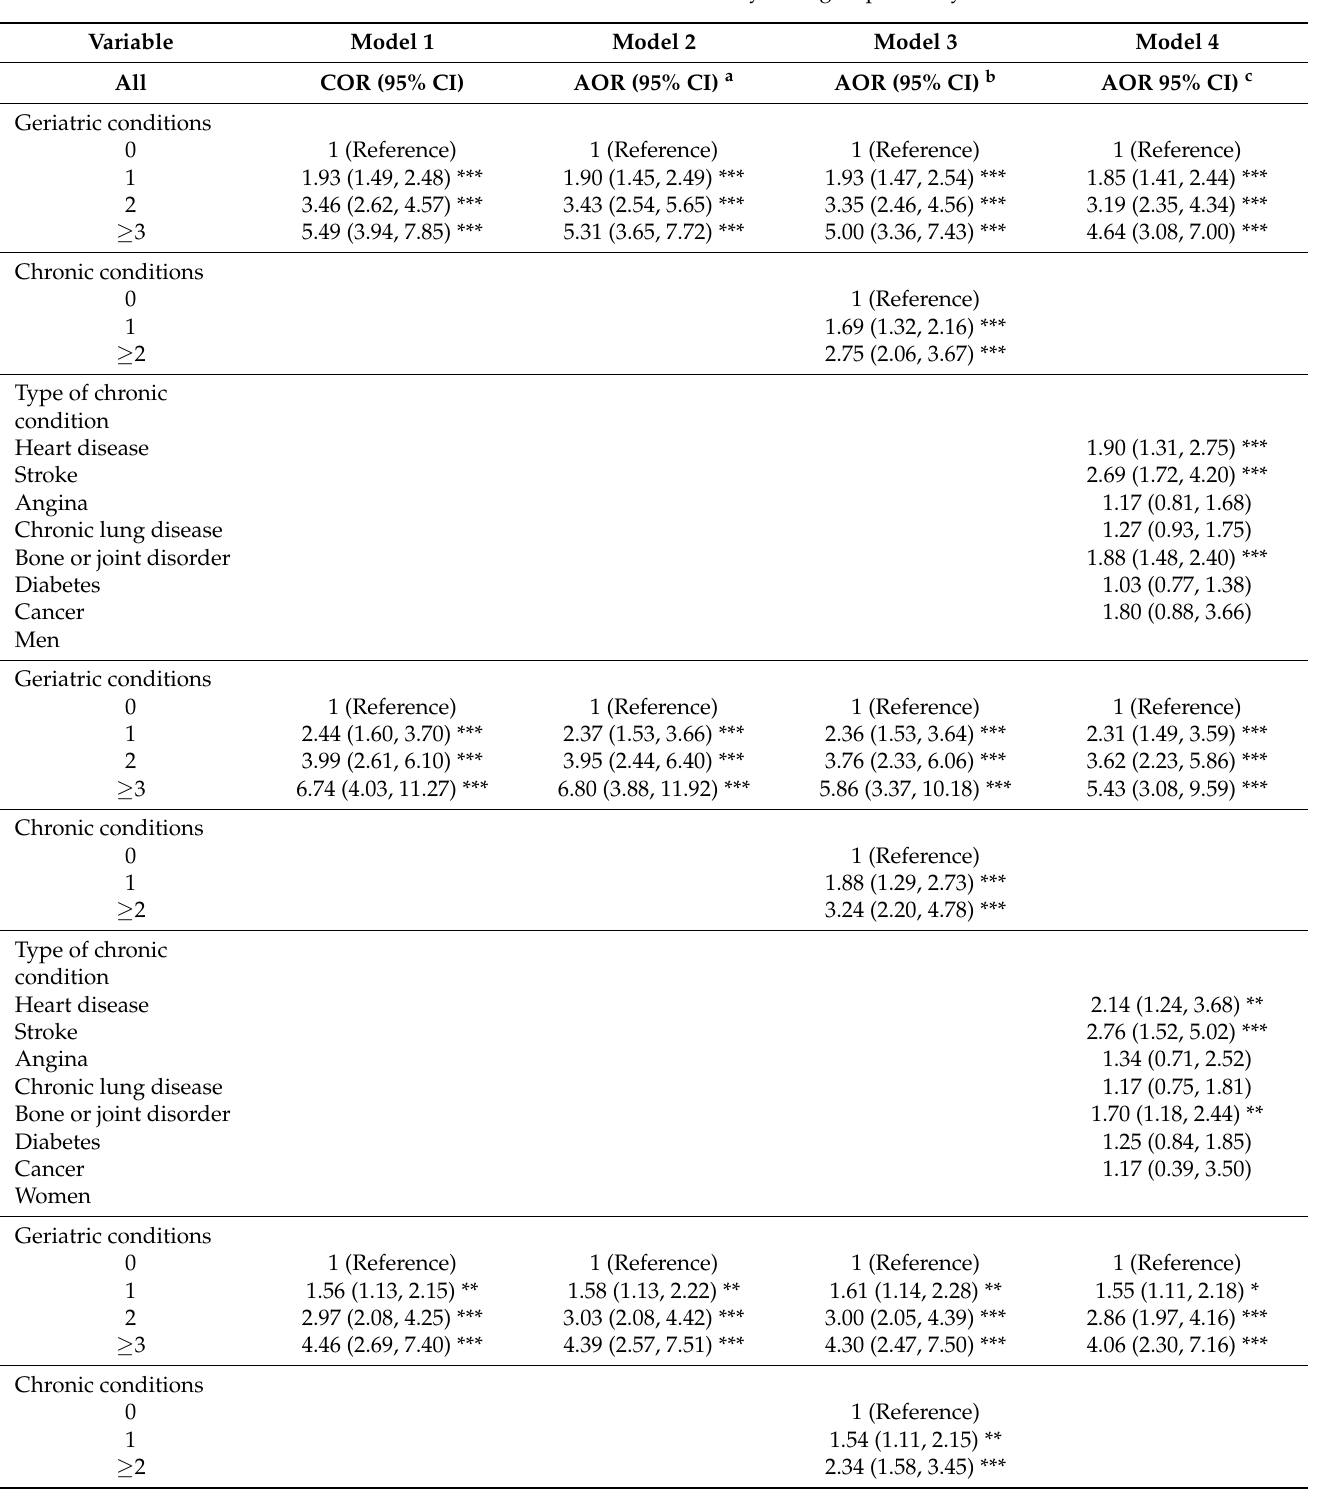
Table 3. Odds ratios for Activities of Daily Living